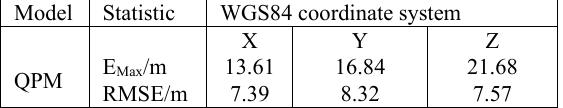
Table 2. Stereo positioning accuracy of